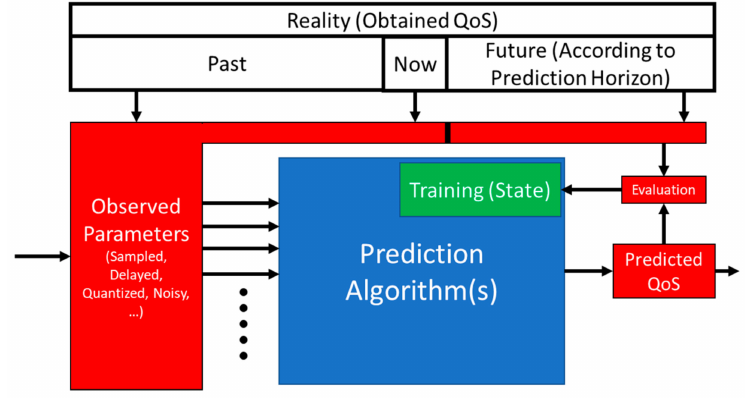
Figure 4. General principle of network quality of service (QoS)